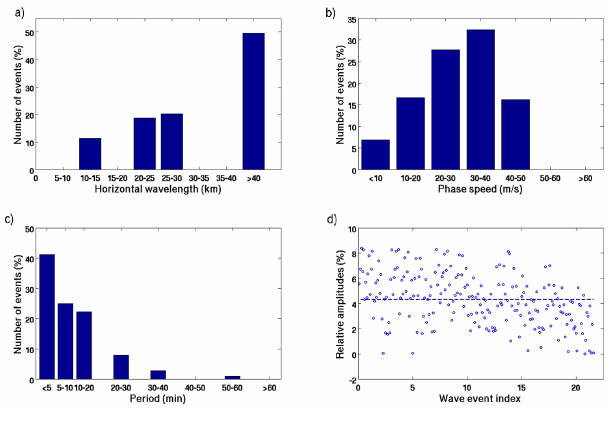
Figure 6. Histograms of the (a) horizontal wavelength, (b) phase speed, (c) period, and (d) relative amplitude (as determined in Sect. 3.2) for each wave event traced from 5 to